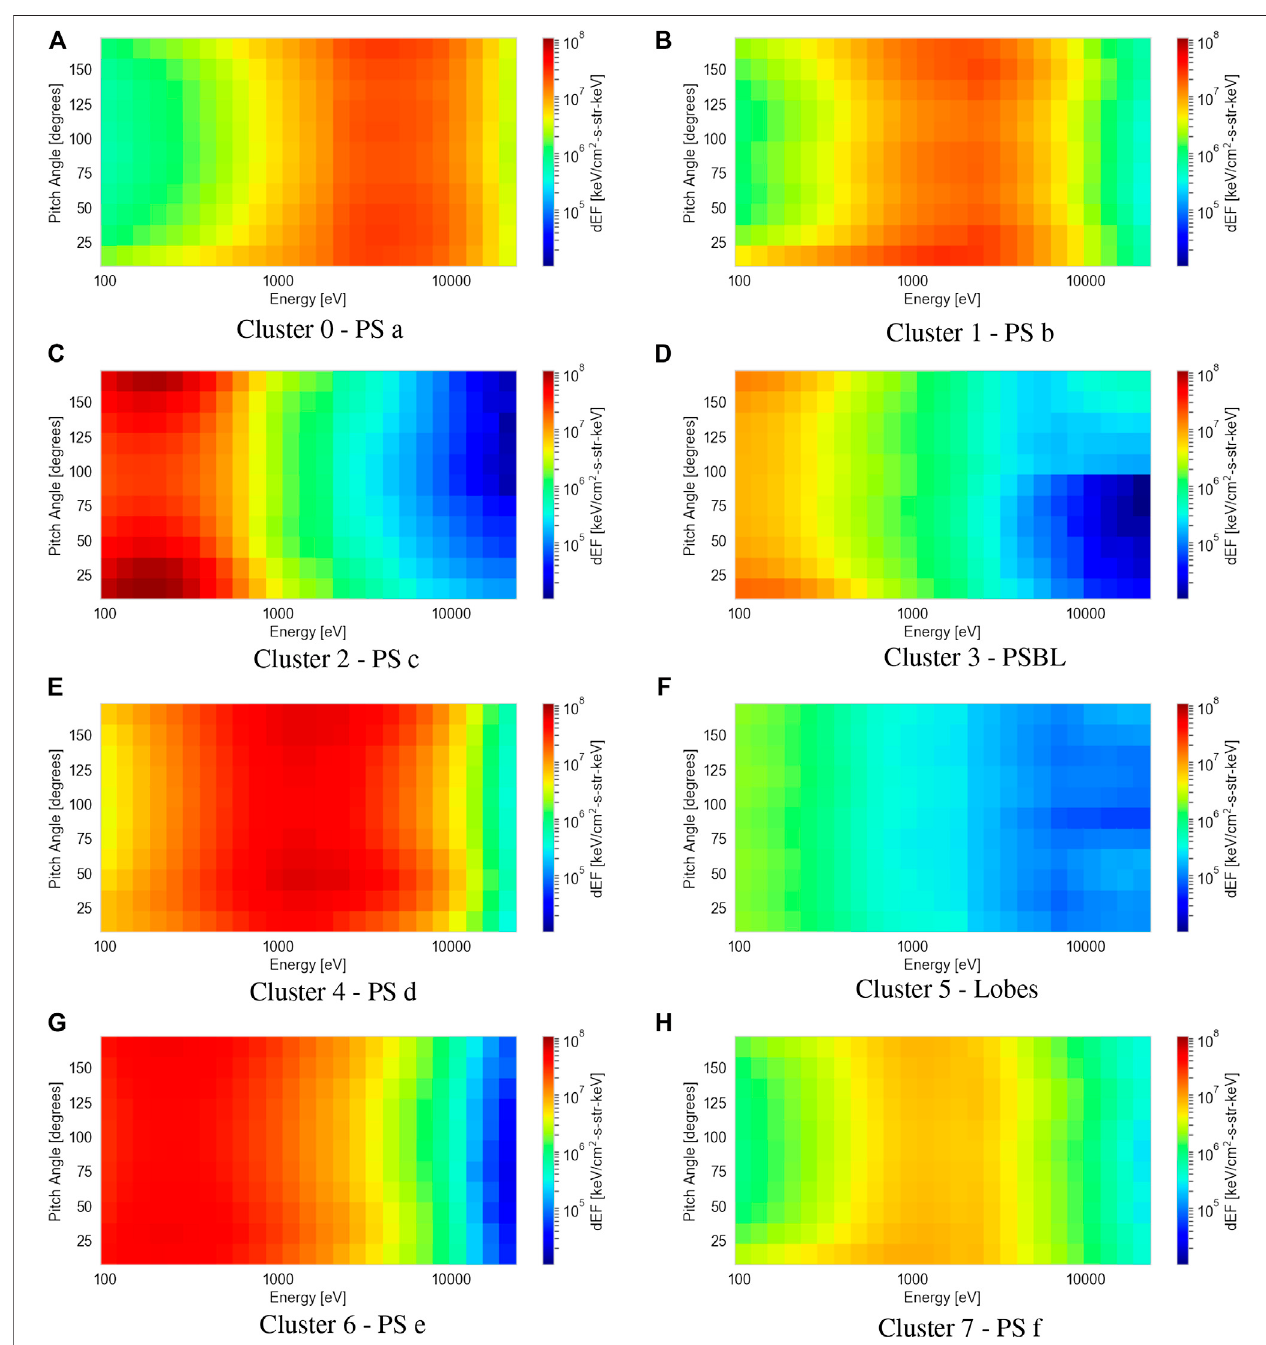
FIGURE 6 | Averageelectrondifferentialenergy fl uxdistributionsasafunctionofpitchangleandenergyforeachoftheeightclusters (A – H) classi fi edbytheagglomerative clustering algorithm. Each cluster is assigned a magnetotail region (included in the subcaptions) based on our interpretation of their plasma and magnetic fi eld parameters.